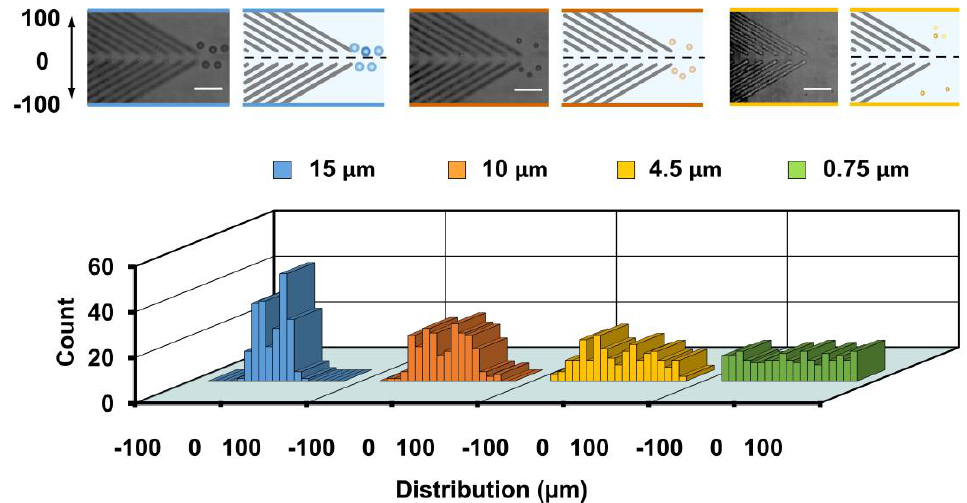
Figure 6. Particle distributions at the end of block 3 (outlet) with an injection flow rate of 1000 nL/min. Histograms of the lateral distributions of 15-, 10-, and 4.5- and 0.75- µ m polystyrene particles are shown. Two hundred particles are measured for each group. Superimposed experimental images and schematics of particles at the layer 15 µ m above the bottom base in the channel with groove structures are presented. Scale bar is 60 µ